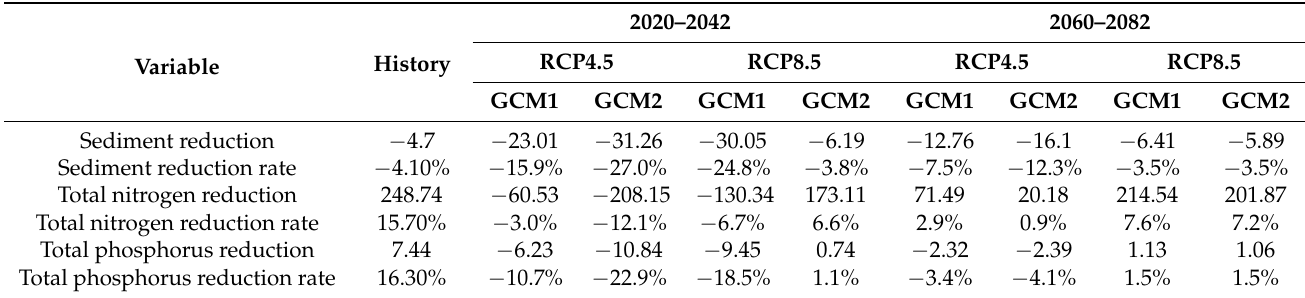
Table 5. Reduction of NPS pollution loads by land use change of historical trend scenarios.